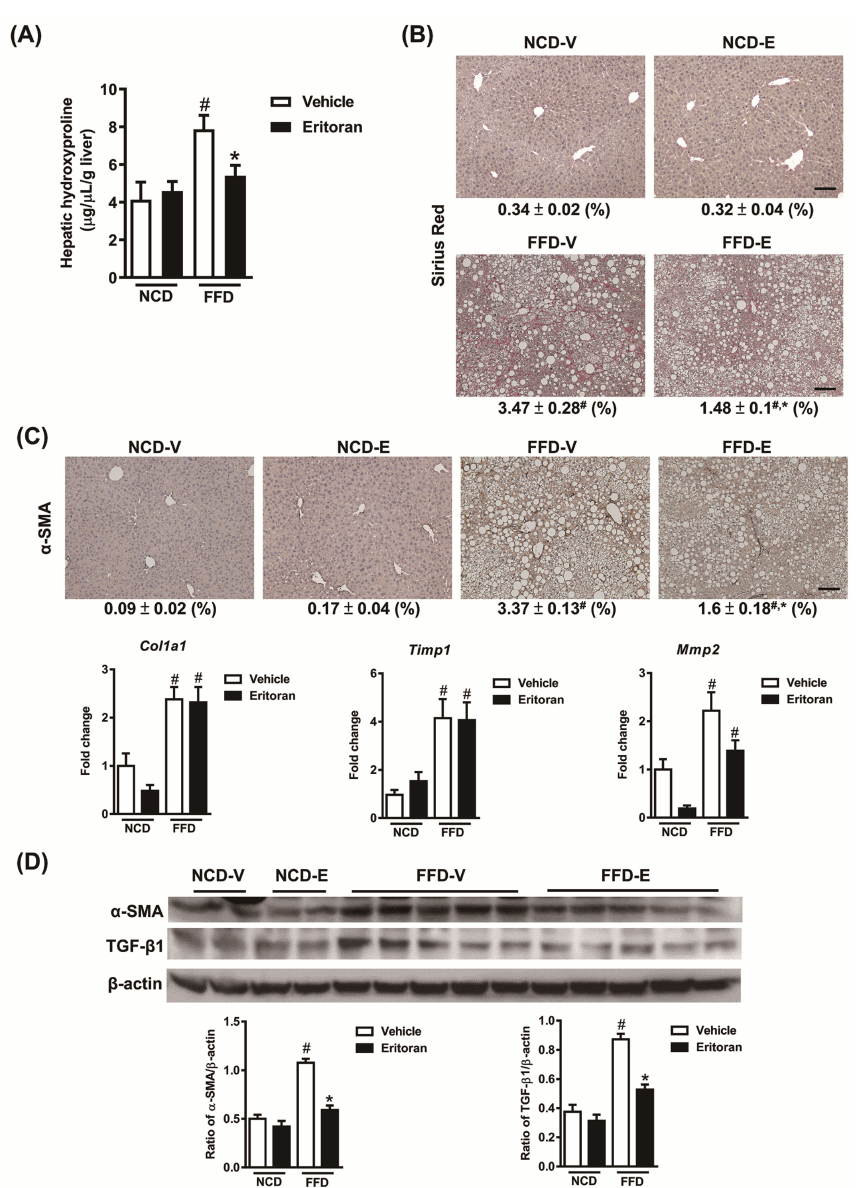
that eritoran attenuated FFD-induced liver inflammation and fibrosis with suppression of HSC activation.